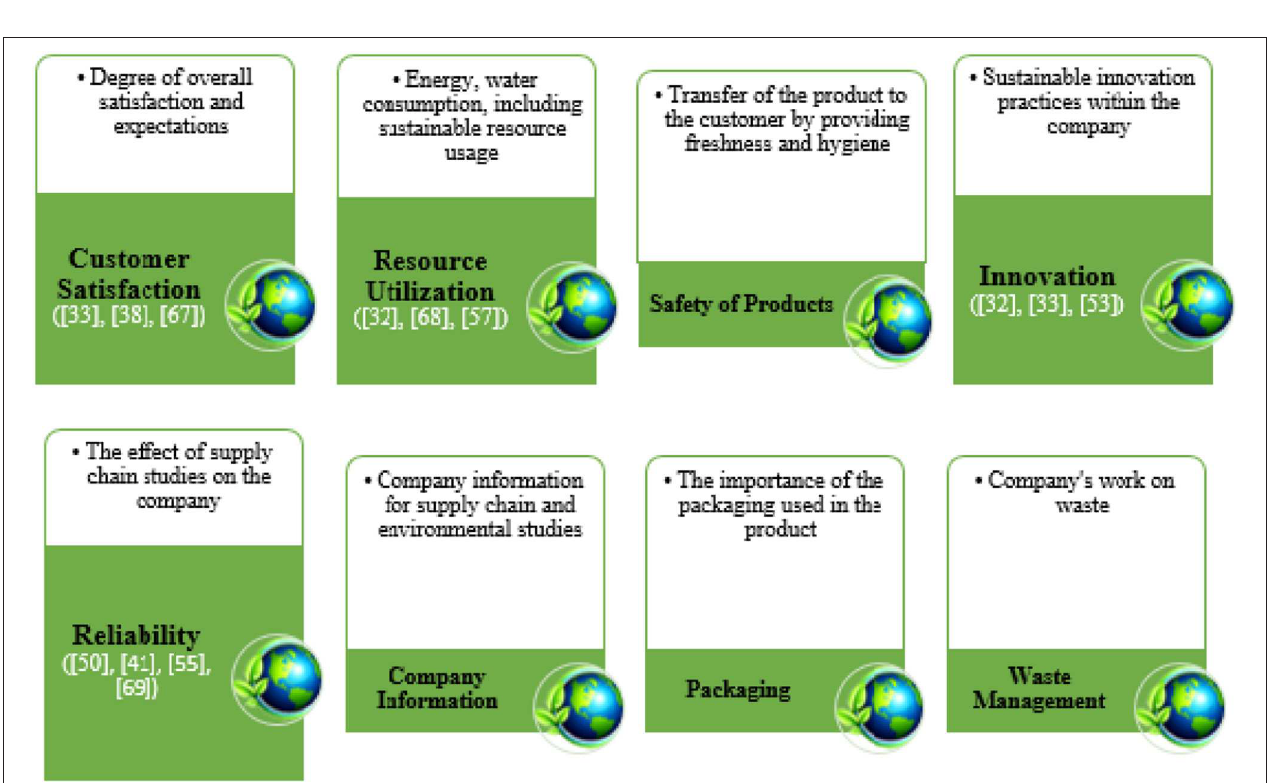
FIGURE 4 | Dimensions of the SFSCM performance indices (latent